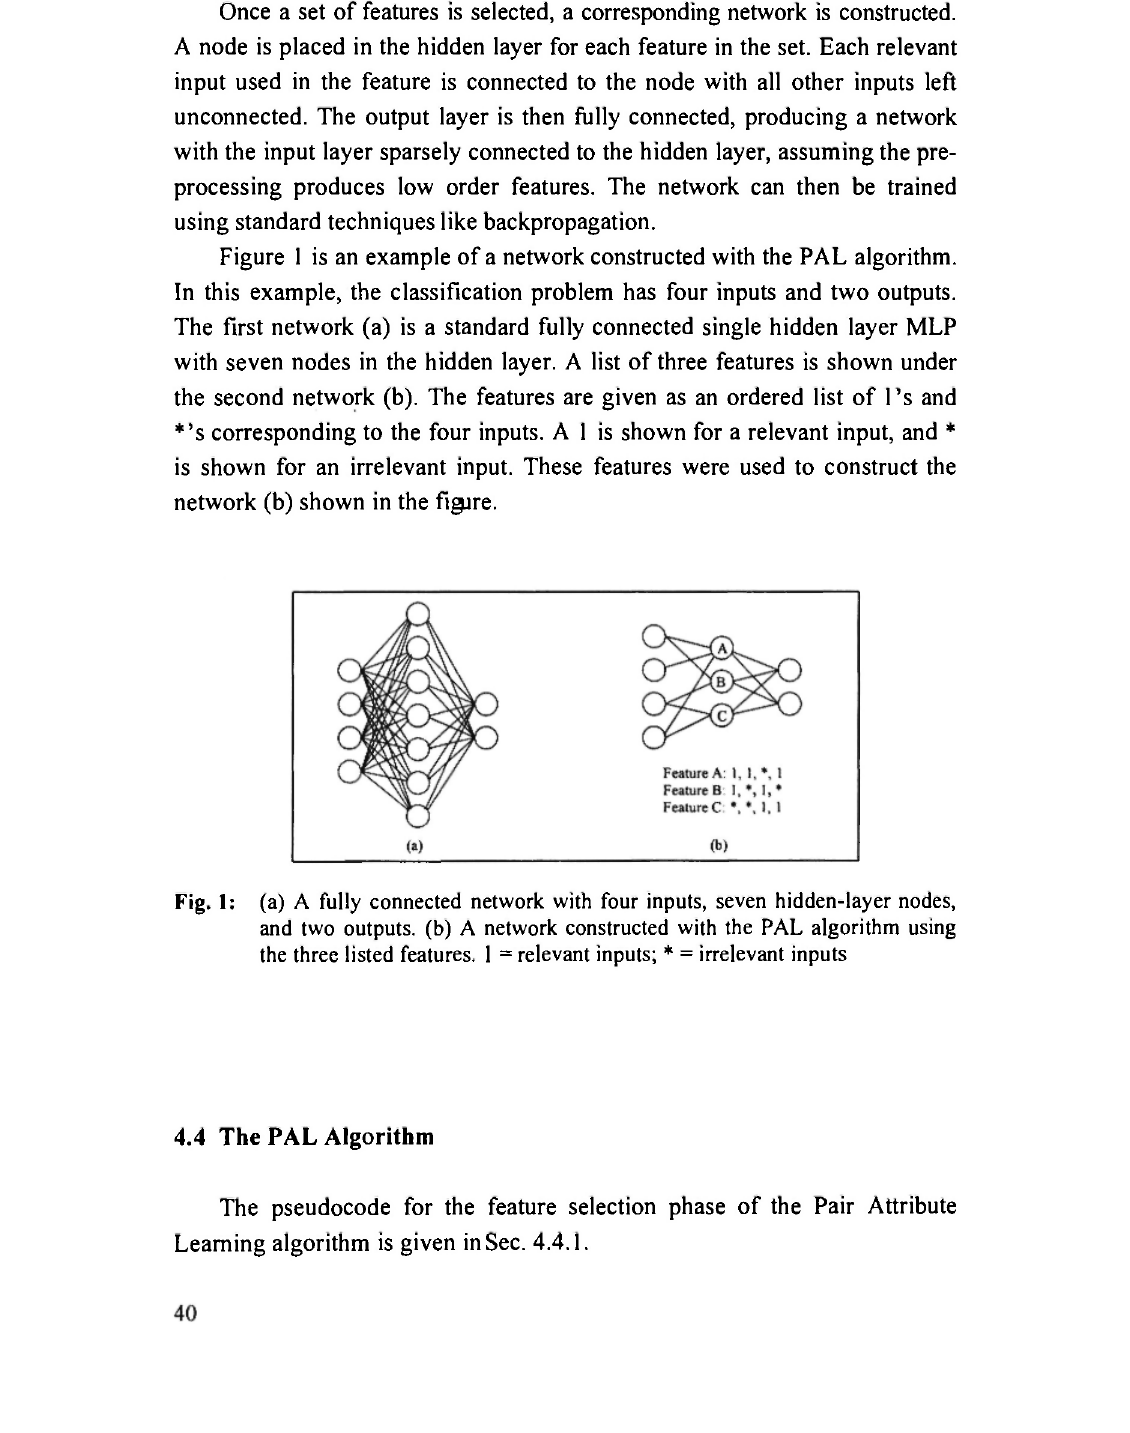
Fig. 1: (a) A fully connected network with four inputs, seven hidden-layer nodes, and two outputs, (b) A network constructed with the PAL algorithm using the three listed features. 1 = relevant inputs; * = irrelevant